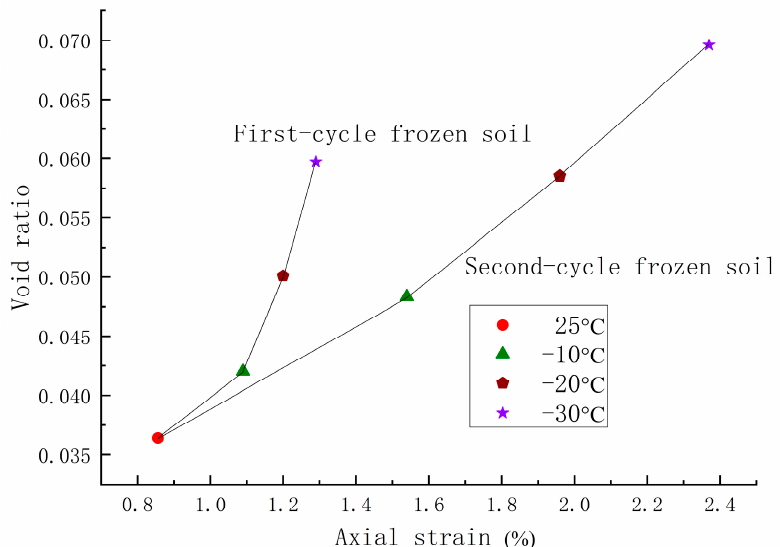
Figure 19. Void ratio vs. axial strain curve.